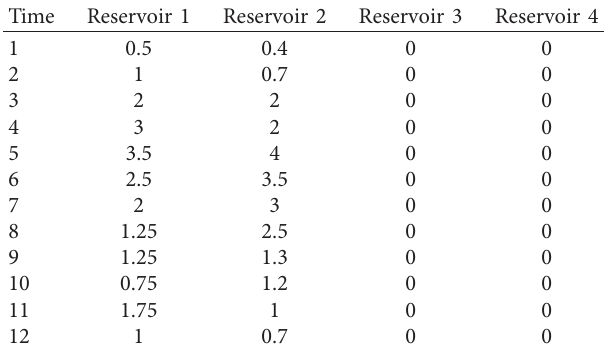
Table 2: Inflows for the CFRO system.